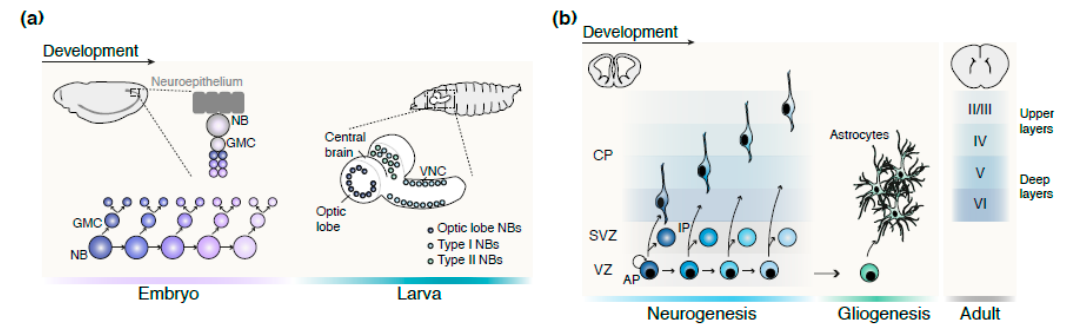
Figure 1. Neural development in Drosophila and in the mammalian cerebral cortex. ( a ) During embryogenesis, NBs delaminate from the neuroepithelium and then divide asymetrically (type I division mode) to produce a GMC. The latter divides once more to produce a pair of neurons that will be successively organized in a laminar manner: the early-born neurons will be located in deeper layers (light purple layer), whereas late-born neurons will be positioned closer to the surface (dark purple layer). At the larval stage, the larval brain is divided into three main regions: the central brain, the optic lobe, and the VNC, each containing various types of NBs. ( b ) During cortical development, excitatory neurons are sequentially generated directly from APs or indirectly from IPs. Neurons born earlier during development will settle in the deep layers of the adult cortex, whereas the upper layers will be composed of later-born neurons. At the end of the neurogenic period, APs undergo a self-consuming division to generate glial cells. Abbreviations: AP, apical progenitors; CP, cortical plate; GMC, ganglion mother cell; IP, intermediate progenitors; NB, neuroblast; VNC, ventral nerve cord; VZ, ventricular zone; SVZ, subventricular zone.